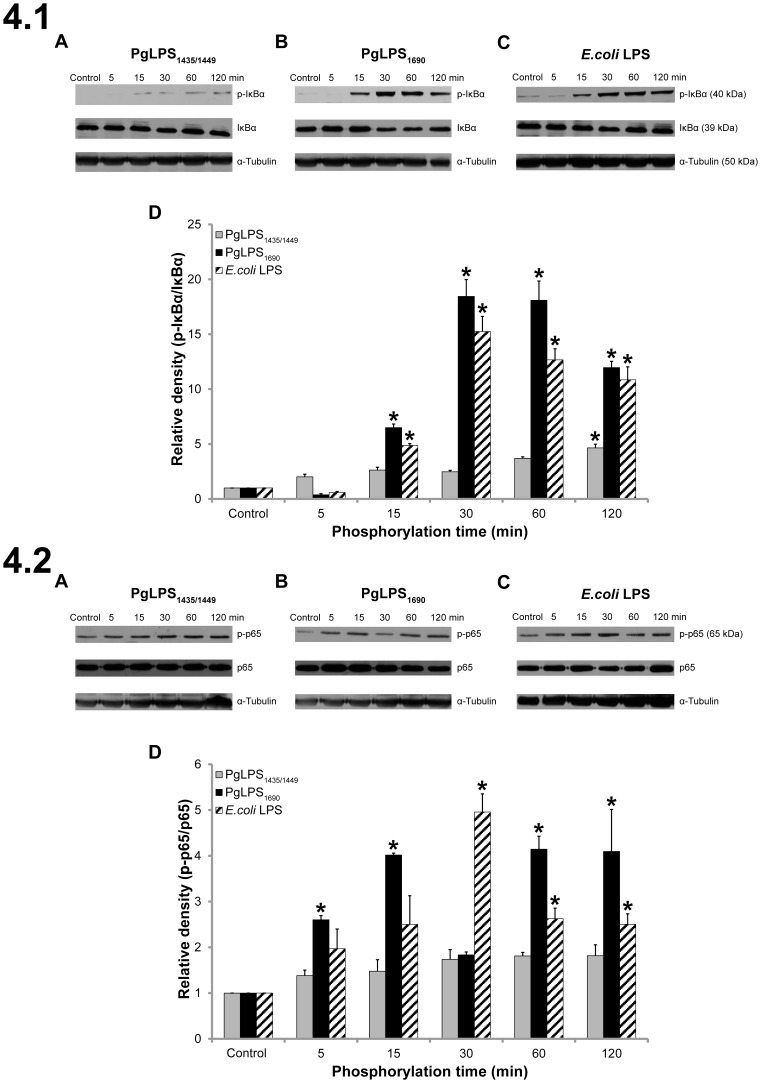

P. gingivalis (Pg) LPS1690 (PgLPS1690) and E. coli LPS activated the NF-κB pathway in HGFs.Kinetics of IκBα and NF-κB p65 phosphorylation in HGFs are shown in 4.1 and 4.2, respectively. Cells were treated with PgLPS1435/1449 (A), PgLPS1690 (B) and E. coli LPS (C) at 1 µg/mL for the indicated period of time. Cell extracts were prepared and the levels of IκBα, phospho-IκBα, NF-κB p65, phospho-NF-κB p65 were determined by western blotting. Equal loading, for each treatment, was confirmed by stripping away the immunoblot, then re-probing it for α-Tubulin. Quantification of band intensities was performed by densitometry analysis using Image J software. The values for fold increase of phospho- IκBα (4.1D) and Phospho-NF-κB p65 (4.2D) as compared with the total protein are shown in the graphs (arbitrary units over control after normalization to the total protein). The data shown here are from a representative experiment repeated three times with similar results. *Significant difference with a p-value <0.05 as compared with the controls without LPS treatment.